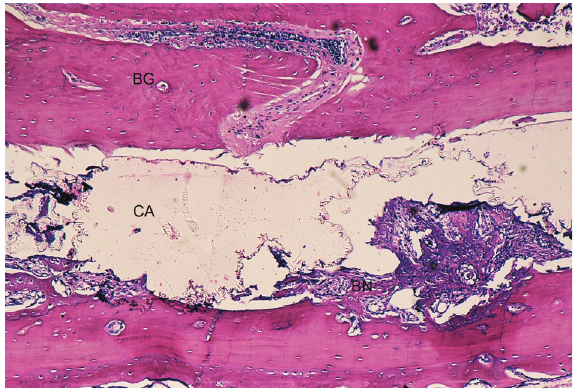
Figure 2- Group II – 10 days: Bone graft (BG) with osteocyte lacunae containing basophilic nucleus. Fragments of the bone graft and the recipient site and discrete areas of new bone formation (BN) can be observed in the recipient site (hematoxylin-eosin - Original